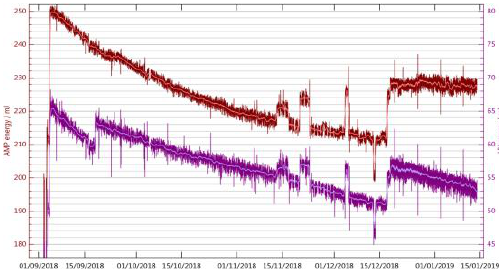
Figure 2 Evolution of laser energy from initial switch- on in September 2018 until mid-January